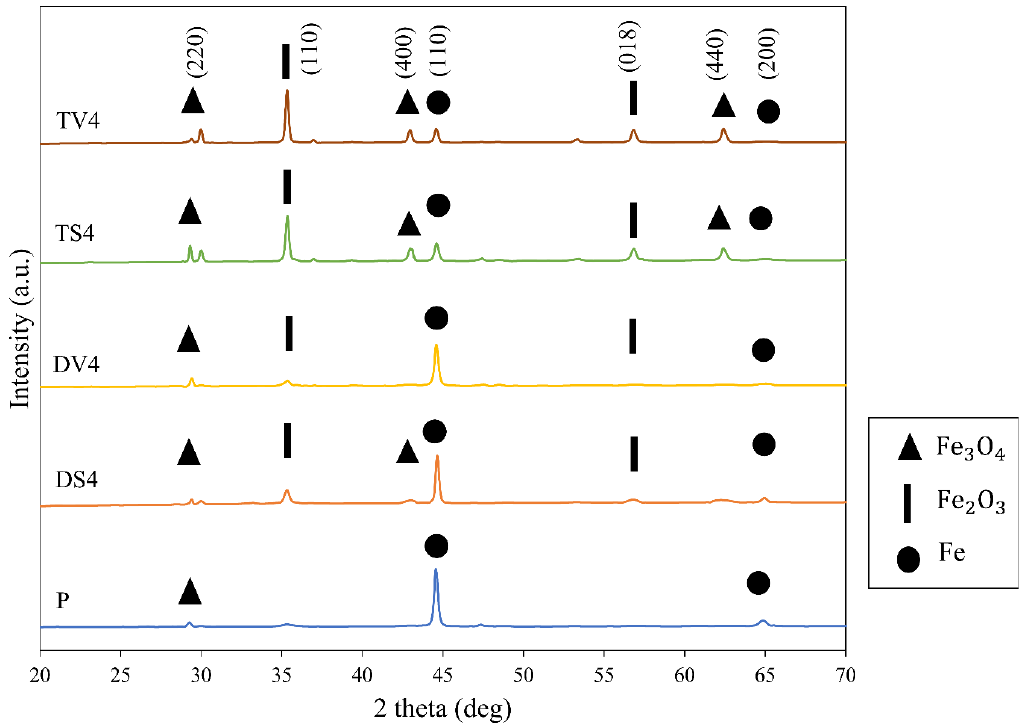
Figure 13. XRD spectra, showing peak corresponding to ferrite, magnetite, and hematite in the orig ‐ inal and worn cutting edges of blades. original and worn cutting edges of